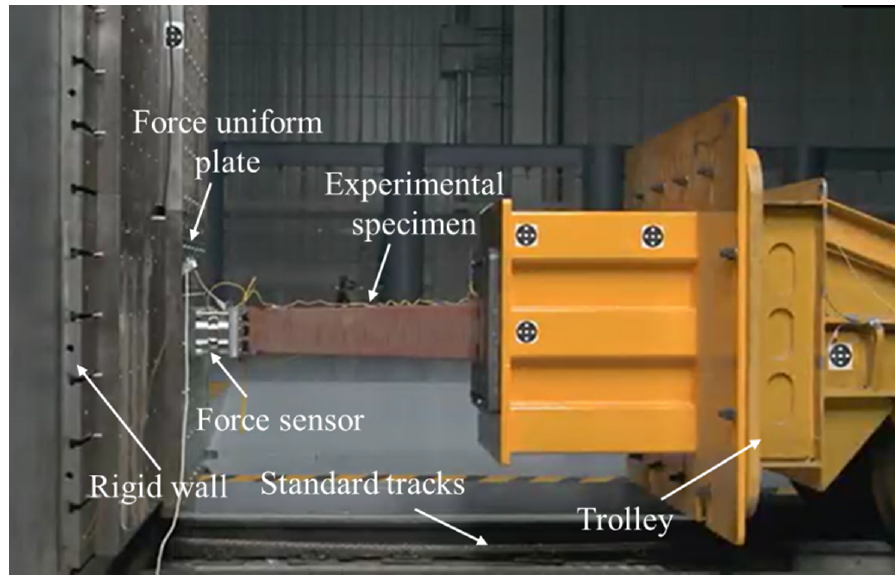
Figure 5. The dynamic impact experiment setup [28]. The whole experimental system consists of rigid walls, uniform force plates, force sensors, an experimental specimen, speedometers, an impact trolley, launch devices and high-speed cameras. The energy-absorbing structure was fixed on the front end of the trolley, and the total weight of the trolley after installation was 16.1 t. The method followed was to drag the trolley to the far end, and then drive the trolley to hit the rigid wall with an initial speed of 17.9 km/h through the motor drive device. The displacement–time curve and the force–time curve of the energy-absorbing structure was obtained with the high-speed camera and the force sensor, respectively. After orthogonal processing of the two, and combined with the previous simulation research of our research group, the force–displacement curve of a single square cone energy-absorbing structure was obtained, as shown in Figure 6a. From Figure 6a, we can see the change trend of the curve. At the beginning of the experiment, the anti-climb teeth of the structure contacted with the rigid wall, the contact force increased to over 500 kN rapidly within about 10 mm of the compress stroke, and then decreased at about the same rate. As the impact progressed further, honeycombs started to be compressed one after another, the force–displacement curve begun to show a clear rise in fluctuations, and this segment was relatively stable. After honeycombs were compressed completely, the structure begun to unload and no longer absorb energy, and the trolley rebounded. In order to study the relationship between the mechanical property of the square cone energy-absorbing structure and the overall energy distribution of the train collision, three parameters: the initial peak force F max , the platform force F and the slope of platform force K, were extracted from the force– displacement characteristic curve to study their influence on urban rail trains, which are shown in Figure